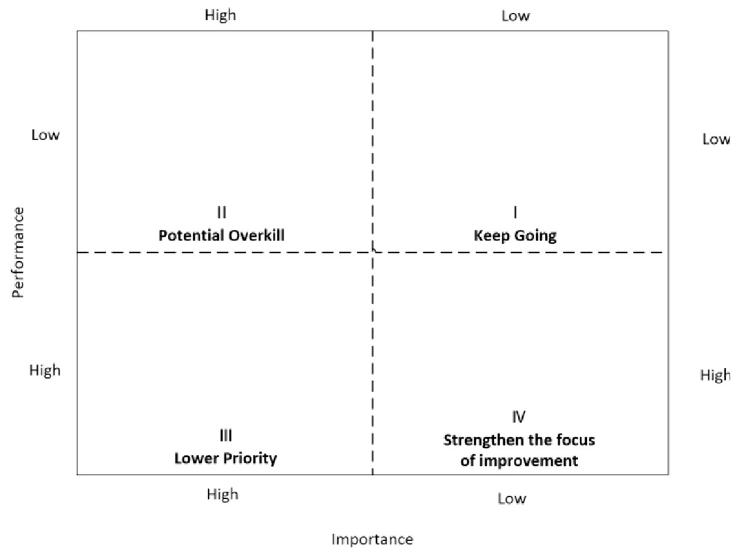
Fig 3. Impact-performance analysis.